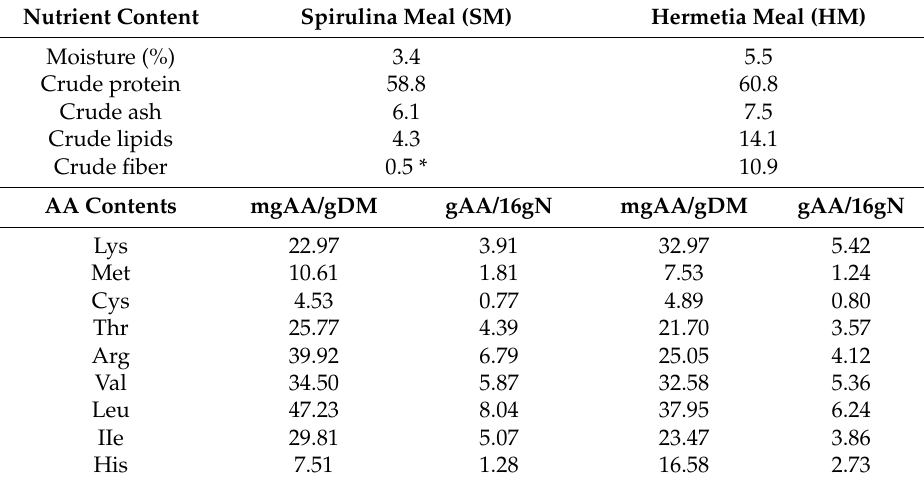
Table 1. Analyzed crude nutrient composition (% of DM) and amino acid content of Spirulina platensis and Hermetia illucens meals as applied for diet